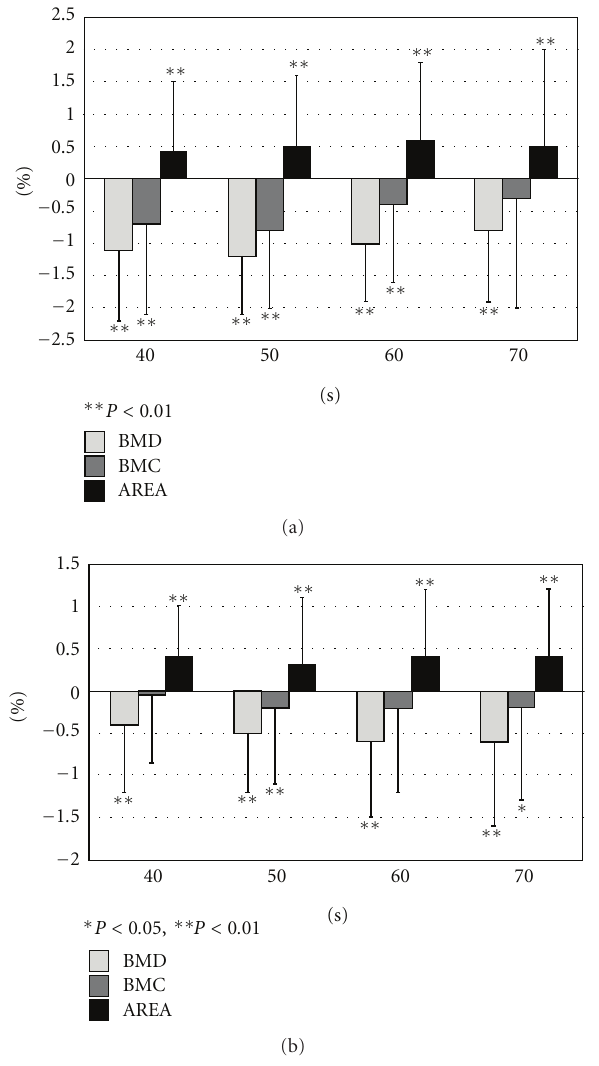
Figure 2: (a) Changes in the femoral neck region by age group in women. Results are the mean ( ± SD) CR of four di ff erent age strata. ∗∗ P < 0 . 01. (b) Changes in the femoral neck region by age group in men. Results are the mean ( ± SD) CR of four di ff erent age strata. ∗ P < 0 . 05, ∗∗ P < 0 . 01.